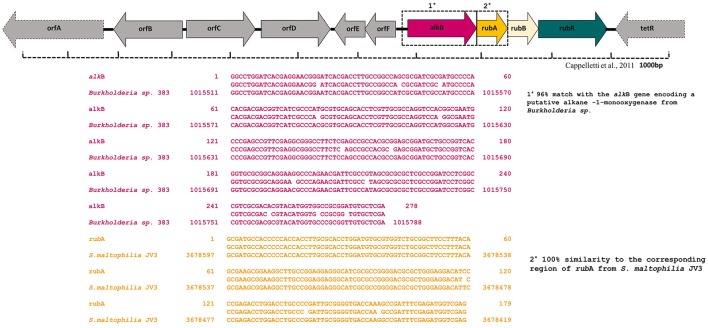
Alignment of alkane monooxygenase (alkB) and rubredoxin (rubA) gene sequences generated using CLUSTALW multiple alignment in S. maltophilia MK2.